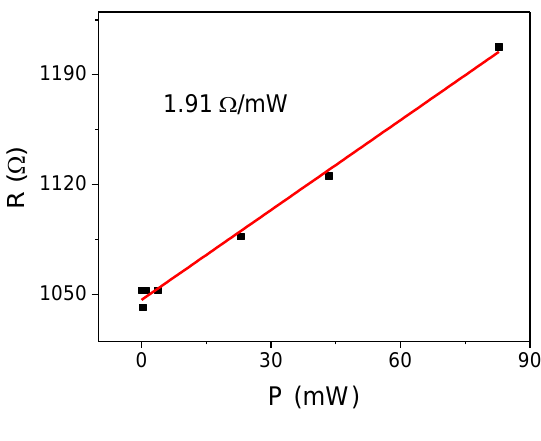
Figure 3. Typical resistance versus power characteristic of the polysilicon heater on porous Si. The red line is a linear fit to the experimental data. The slope of the curve (resistance variation with power) is found to be 1.91